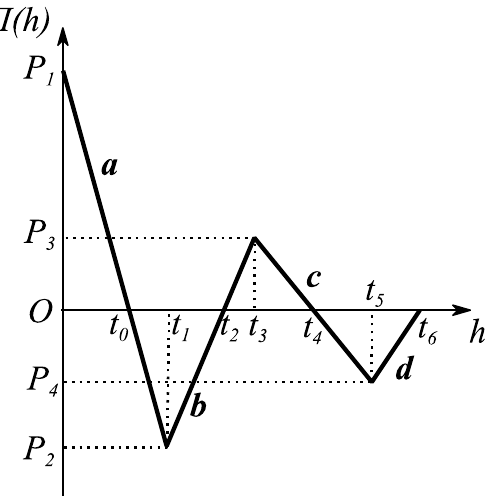
Figure 10. Linear (piece-wise) disjoining/conjoining pressure isotherm for quasi-equilibrium cases. Reproduced with permission from [20]. Copyright © 2018 Elsevier B.V. Table 2 . Properties of disjoining/conjoining pressure isotherm for advancing/receding contact angles [20].